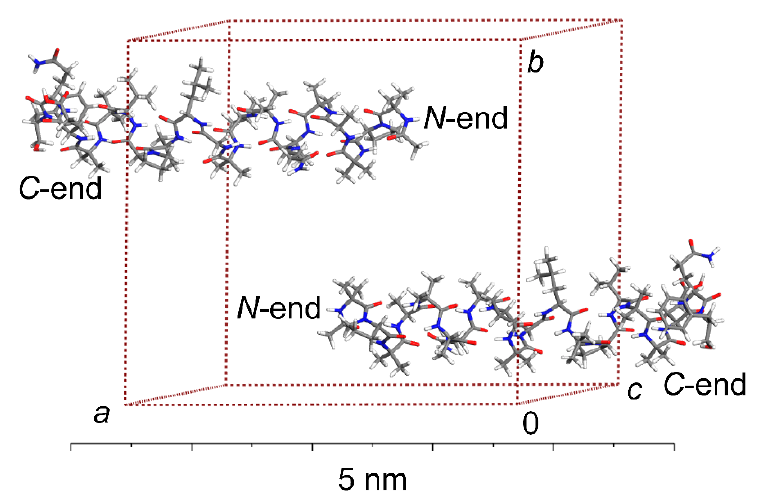
Figure 1. The crystallographic unit cell of ALM-18 model. Color-coding of the sticks: white, grey, blue, and red for hydrogen, carbon, nitrogen, and oxygen atoms, respectively.